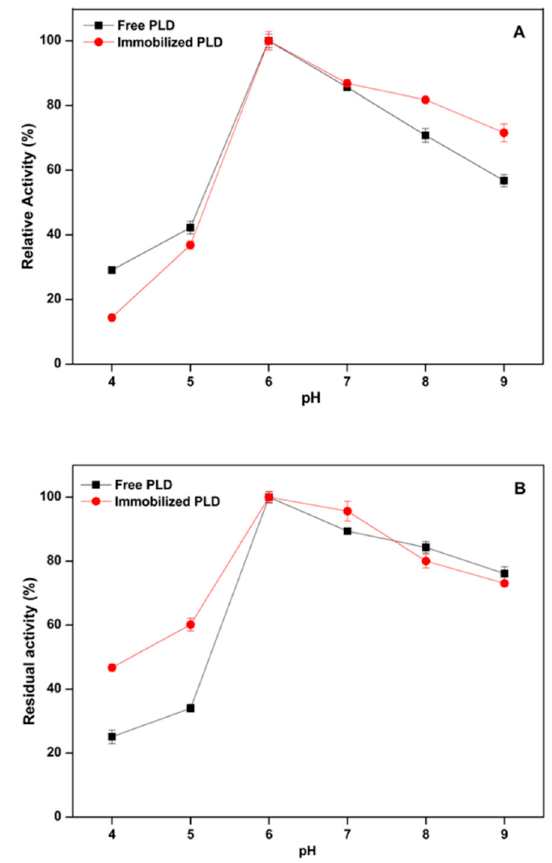
Figure 6. E ff ect of pH on the enzyme activity (A) and stability (B) of the free and immobilized PLD a2 .